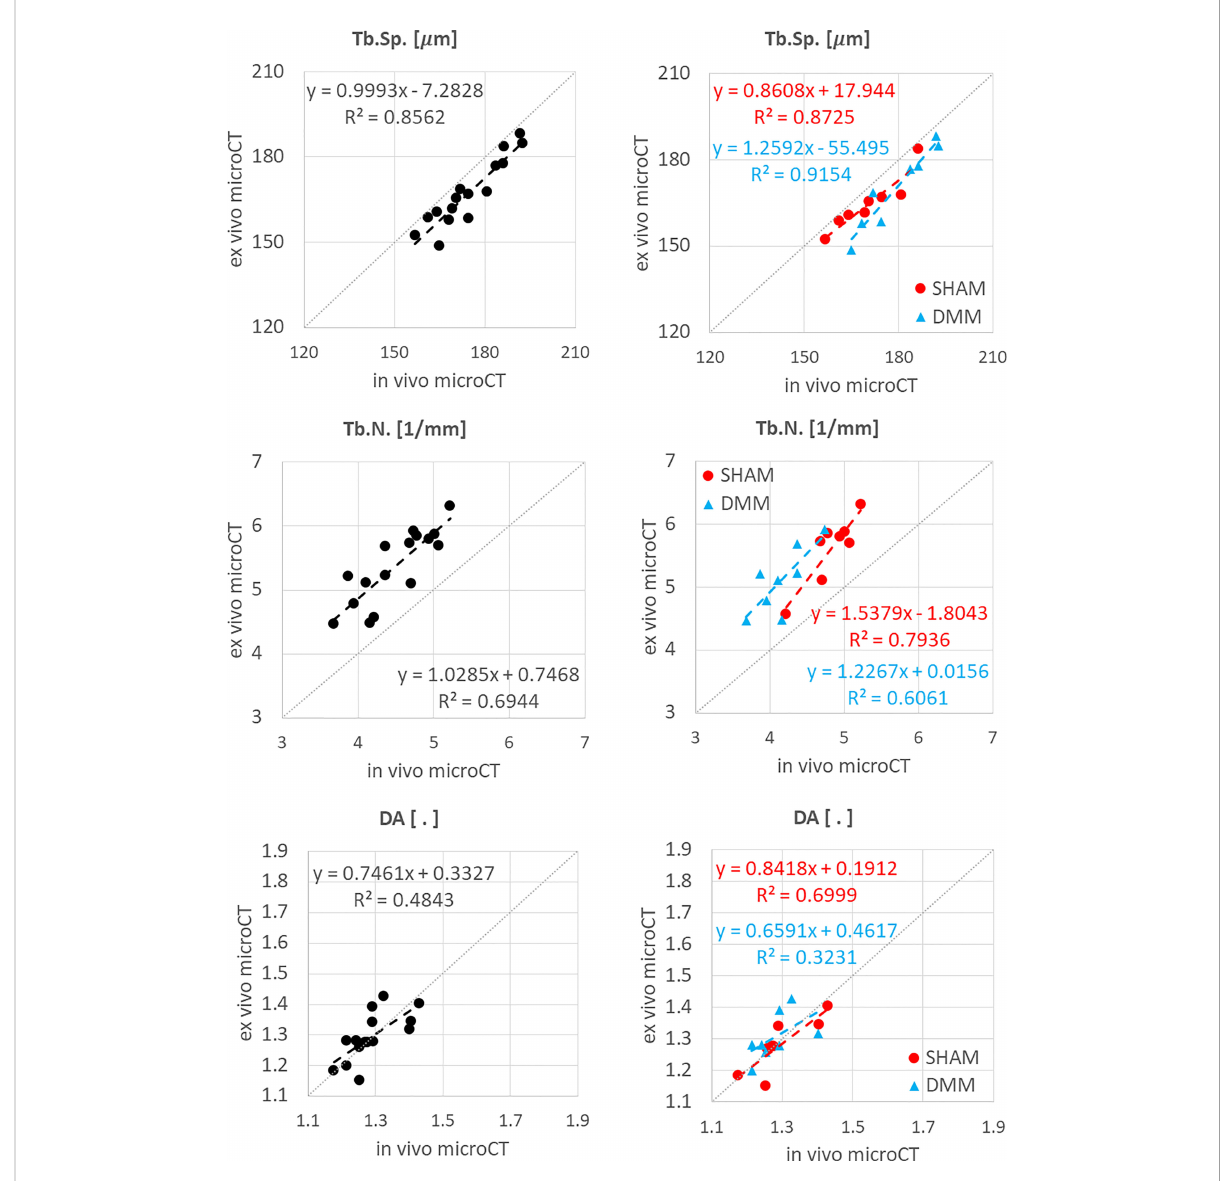
FIGURE 5 Regression analyses between in vivo and ex vivo measurements for trabecular separation (Tb.Sp), number (Tb.N) and degree of anisotropy